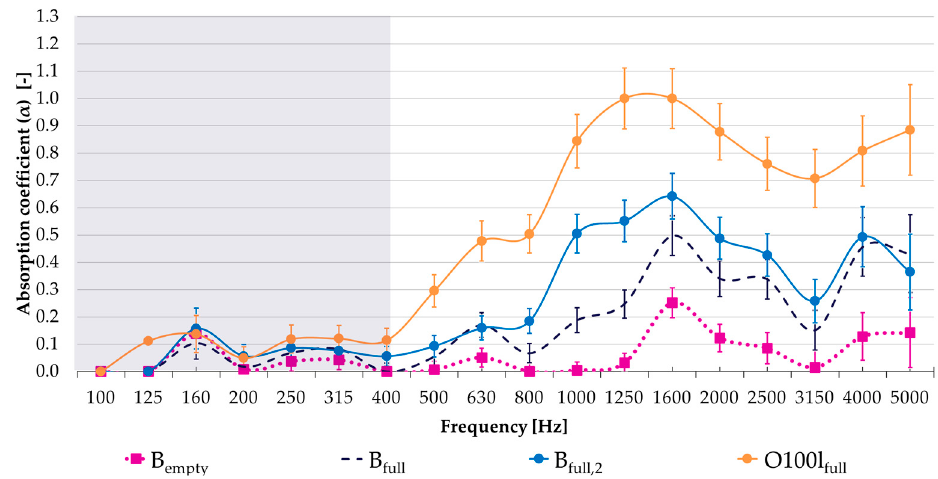
Figure 13. The obtained random incidence sound absorption coefficients of the B empty , B full , B full,2 , and O100l full configurations, together with the standard deviations of the results of each sample configuration.